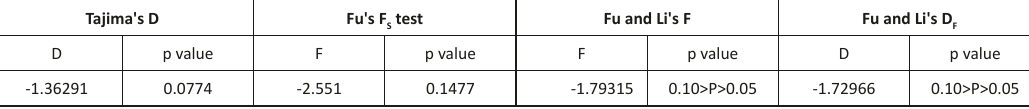
, and Fu and Li’s F and D S